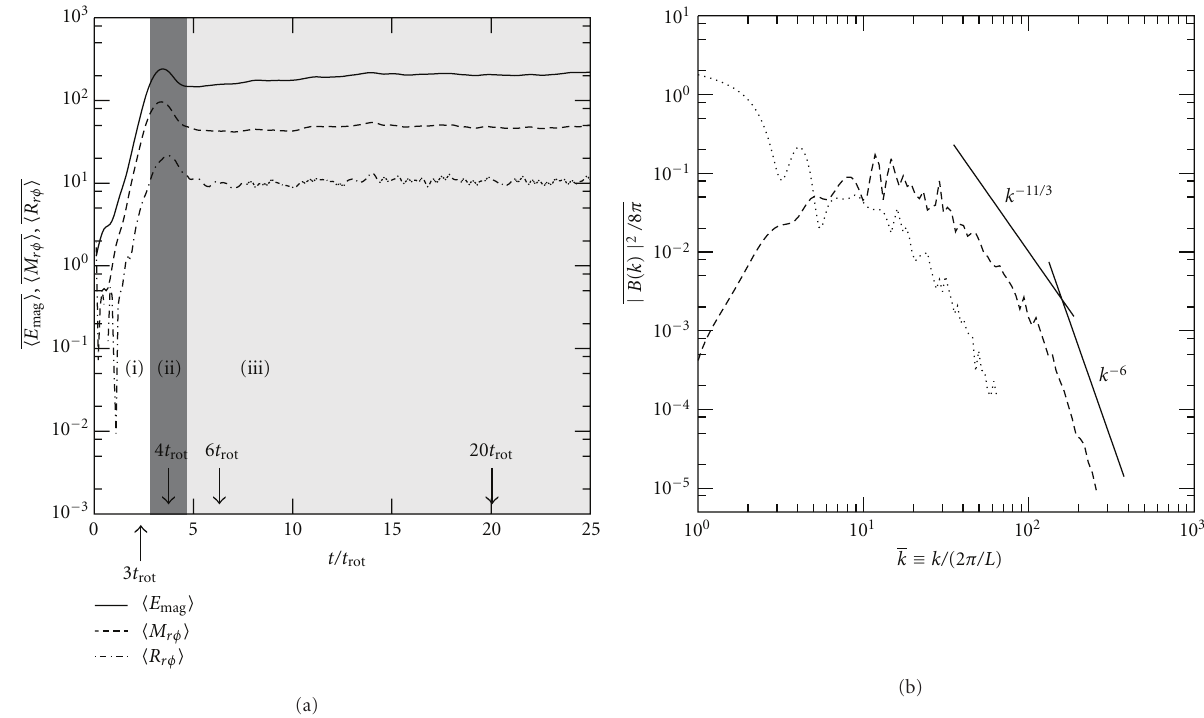
Figure 19: (a) Temporal evolution of the volume averaged magnetic energy, Maxwell and Reynolds stresses in the fiducial run are represented by thick, dashed, and dash-dotted curves, respectively. The vertical axis is normalized by the initial magnetic energy E mag,0 ≡ B 2 0 / 8 π , that is (cid:5) E (cid:6) ≡ (cid:5) E (cid:6) /E (cid:5) M rφ (cid:6) ≡ (cid:5) M rφ (cid:6) /E (cid:5) R rφ (cid:6) ≡ (cid:5) R rφ (cid:6) /E mag mag mag,0 , mag,0 , and mag,0 where single bracket denotes the volume average of the physical variables. Horizontal axis is normalized by the rotational period t rot ≡ 2 π/ Ω . Three typical evolutionary stages, (i) exponential growth stage, (ii) transition stage, and (iii) nonlinear turbulent stage, are denoted by white, dark gray, and light gray shaded regions. (b) The amplitude of power spectra of the magnetic energy | B ( k ) | 2 along the k x and k z axes. The dashed and dotted curves describes the k x and k z components respectively. The vertical axis is normalized by the initial magnetic energy E mag,0 . The wave-numbers shown in the horizontal axis are normalized by the 2 π/L . The upper thick curve demonstrates the Kolmogorov slope for isotropic incompressible turbulence ∝ k − 11 / 3 . The lower slope is proportional to k − 6 just for the reference. In our local simulations, we prepare a 2D shearing box which is threaded by the initial vertical field B 0 = 1 . 4 × 10 12 G with imposing initial gas pressure P 0 = 4 × 10 28 dyncm − 2 , angular velocity Ω 0 = 2000sec − 1 and shear parameter q 0 = 1 . 25, respectively. Here the shear parameter represents the degree of di ff erential rotation as q ≡ − d ln Ω /d ln r with r being the radial coordinate. The other parameters are fixed to mimic the properties in the vicinity of the PNS’s surface in the postbounce phase (i.e., the density is taken to be ρ 0 = 10 12 gcm − 3 and the box size is taken to be L x = 4 km (horizontal) × L z = 1 km